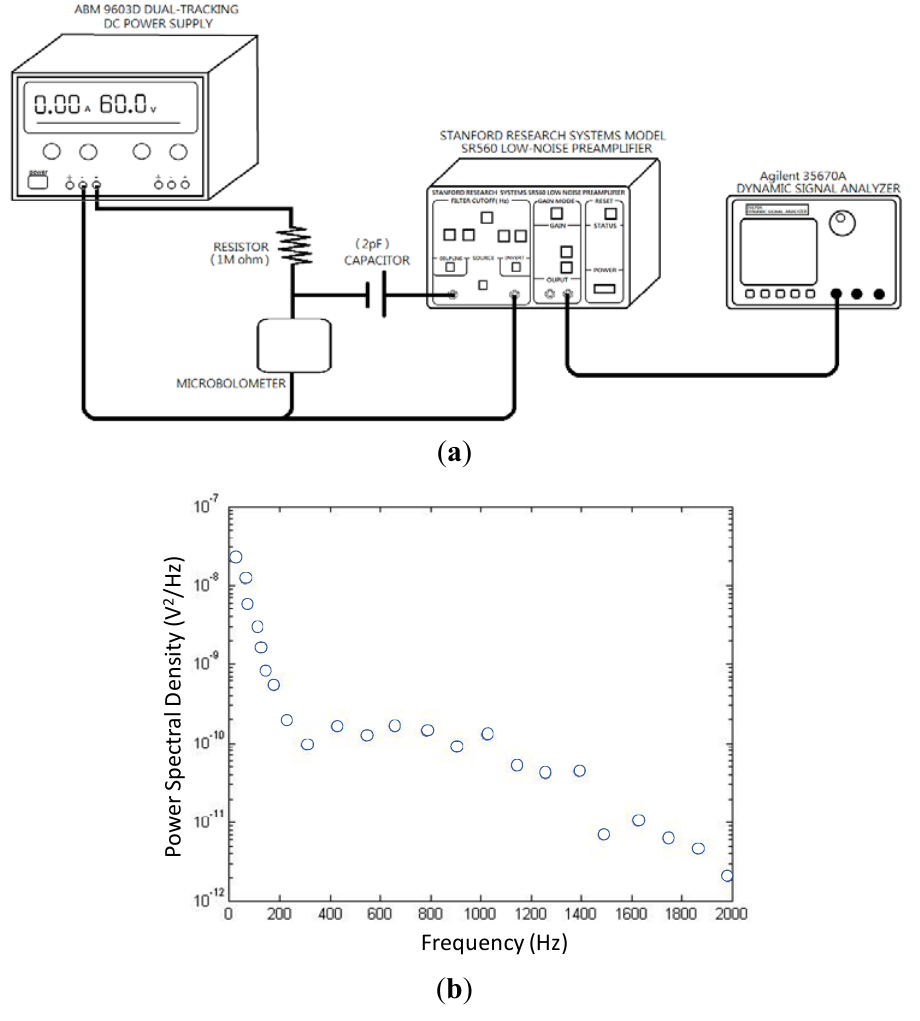
Figure 11. ( a ) Schematic drawing of noise measurement setup (using 1 M Ω resistor and 2 pF the capacitor), and ( b ) measured noise power spectral density versus